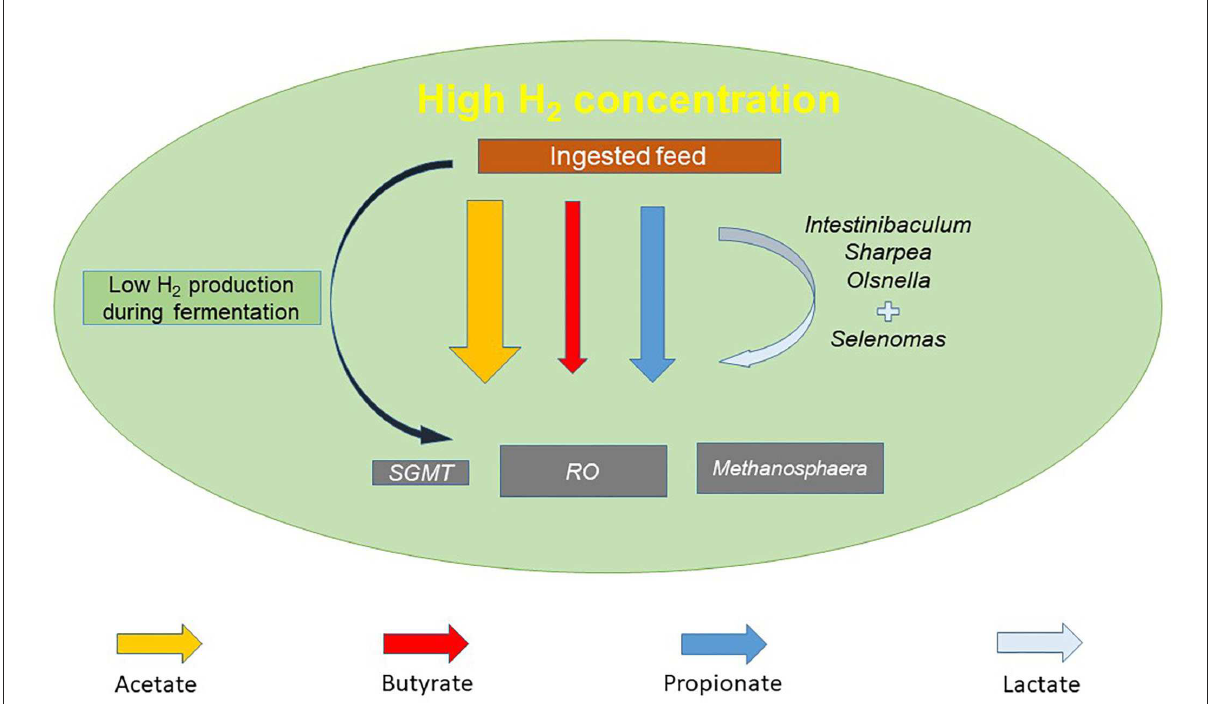
FIGURE1 An overview of the rumen microbial community and fermentation profile of a low residual methane emissions (RME) phenotype based on the findings of Smith et al. (54). Differences in the size of the shapes representing individual volatile fatty acids (VFAs) and rumen methanogens are reflective of the dominant VFAs methanogen genera in low RME